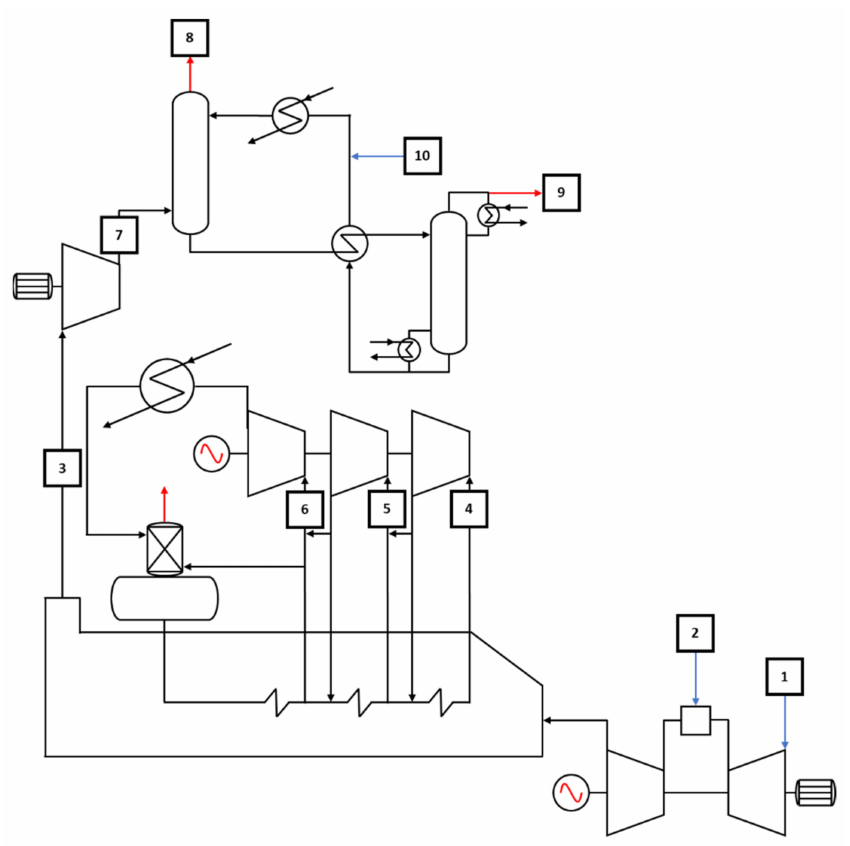
Figure 4. Power Plant—PCCC block scheme (the numbers represent the flow rates between the units). Table 2. Power Plant and PCCC Process